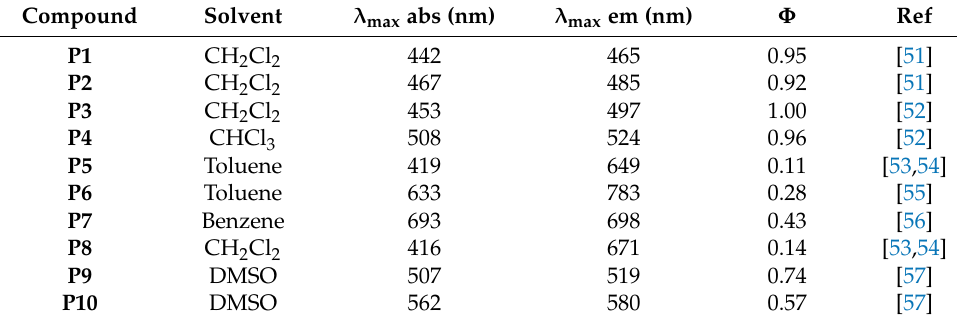
Table 2. Test group composed by related pyrrole-based